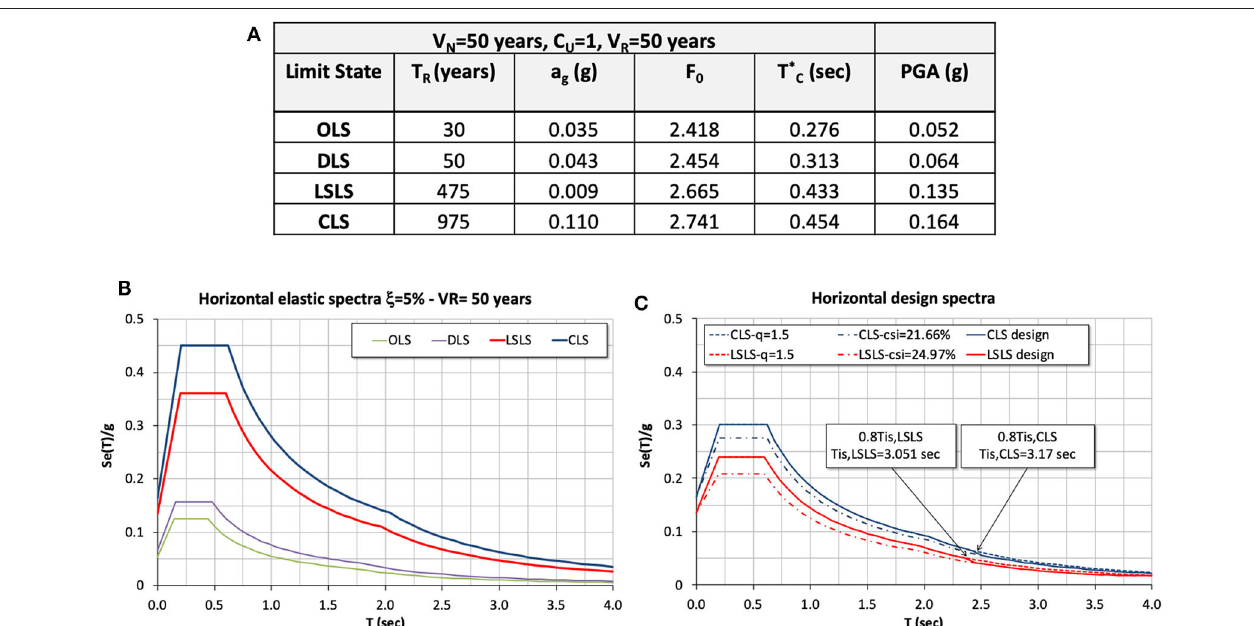
FIGURE 3 | Site seismic hazard and response spectra. (A) Parameters defining the seismic action referred to a rigid soil (Type A) for each limit state, and PGA referred to a soil Type C. (B) Horizontal elastic response spectra ( ξ 5%), and (C) design spectra for LSLS and CLS considering a soil Type =